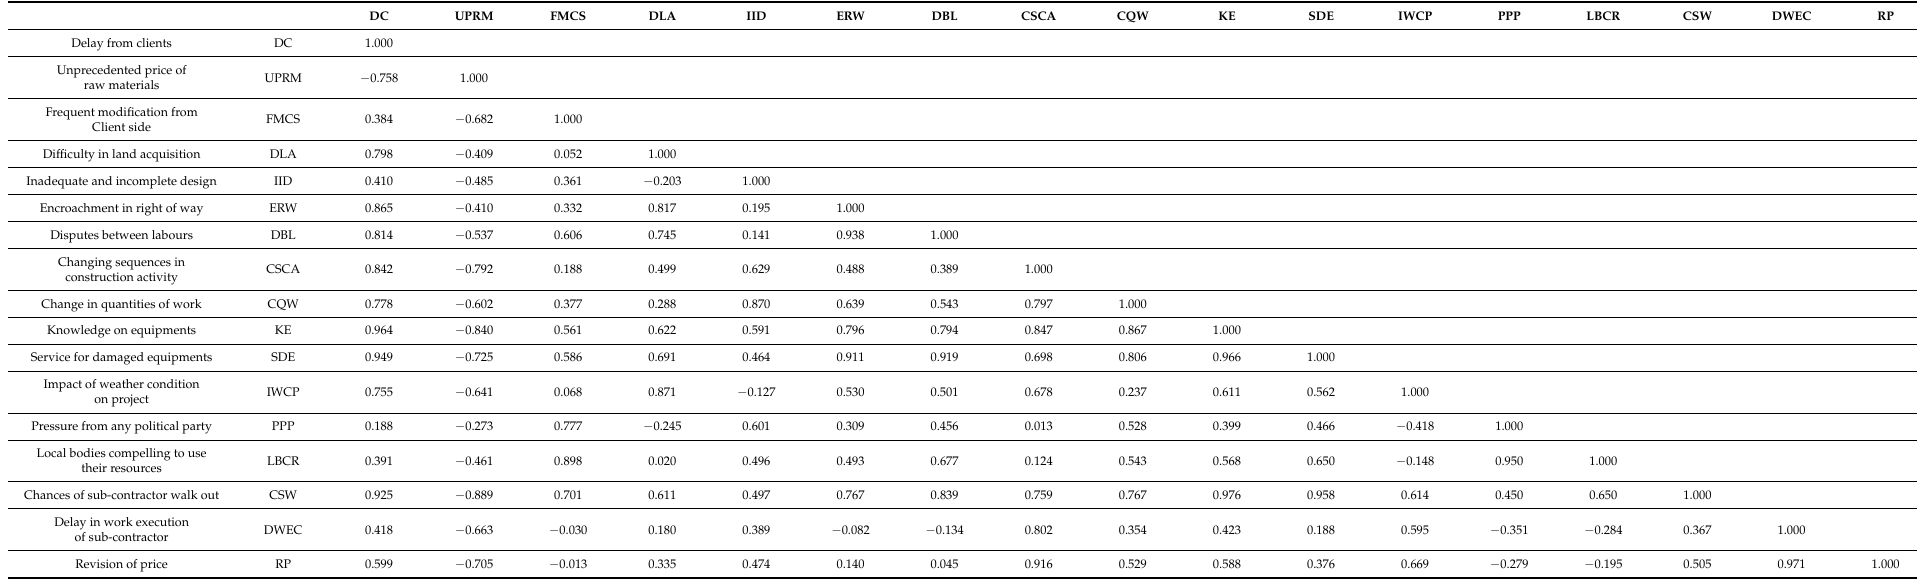
Table 4. The coefficient correlation between